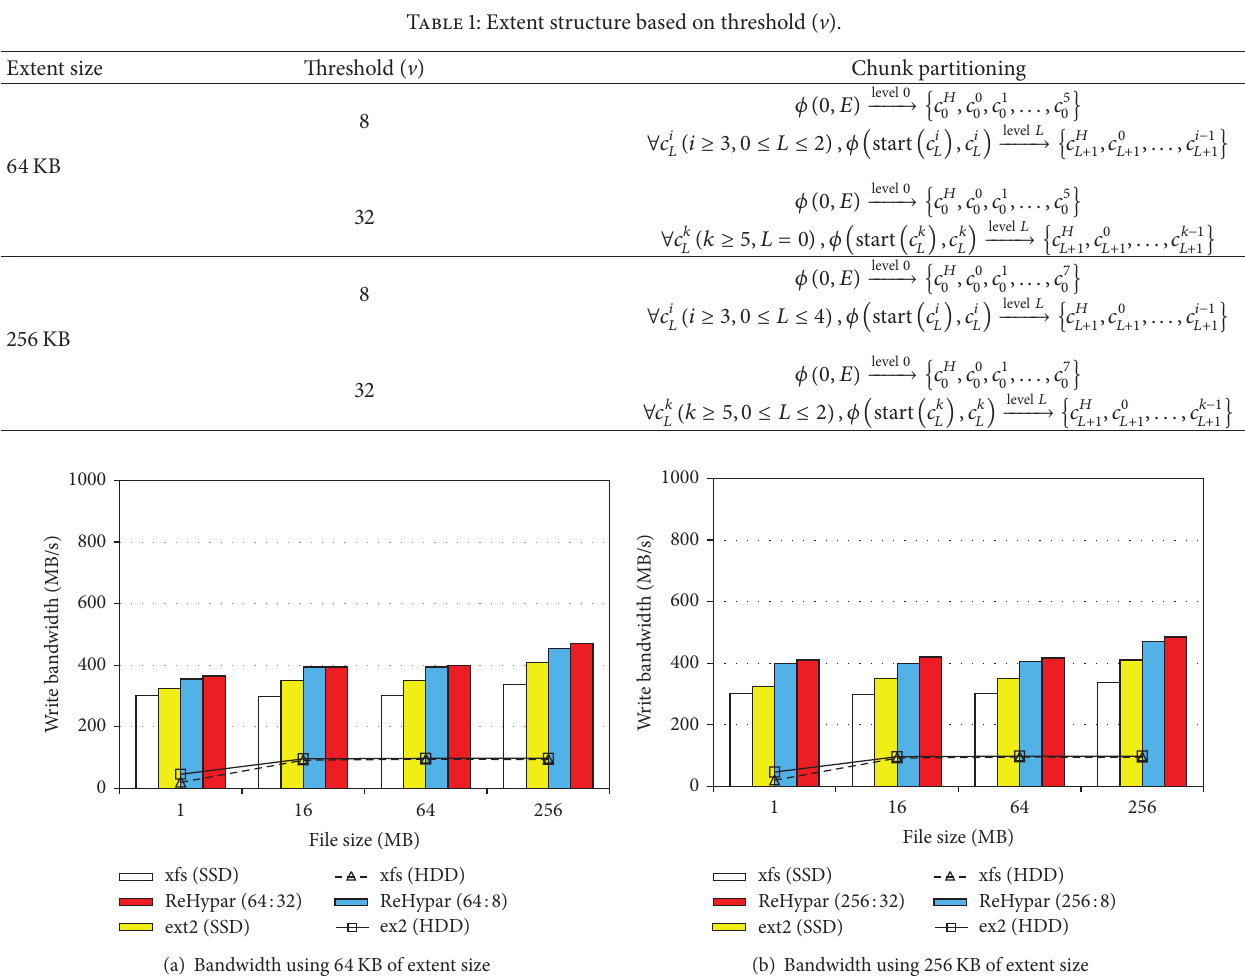
Figure 3: ReHypar write bandwidth as compared to ext2 and